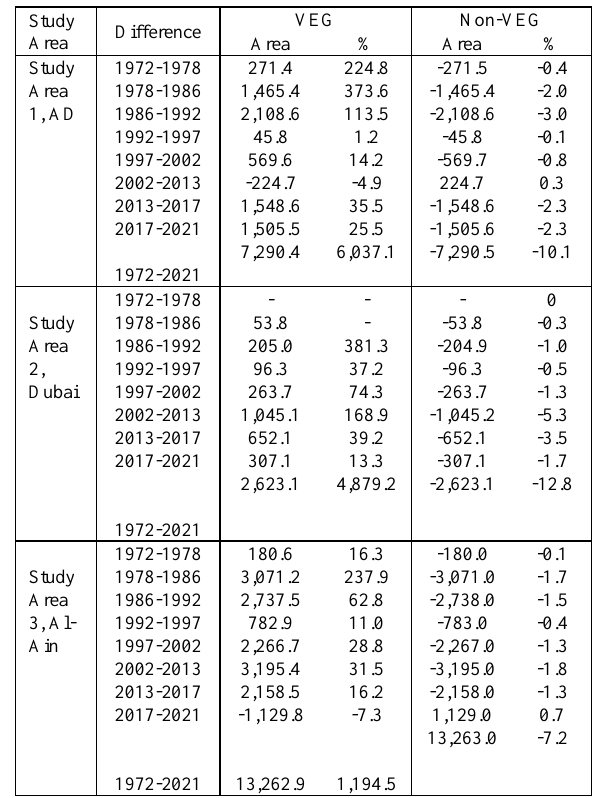
Table 13 . VEG and Non-VEG changed areas in hectare (ha) and percentages during the study